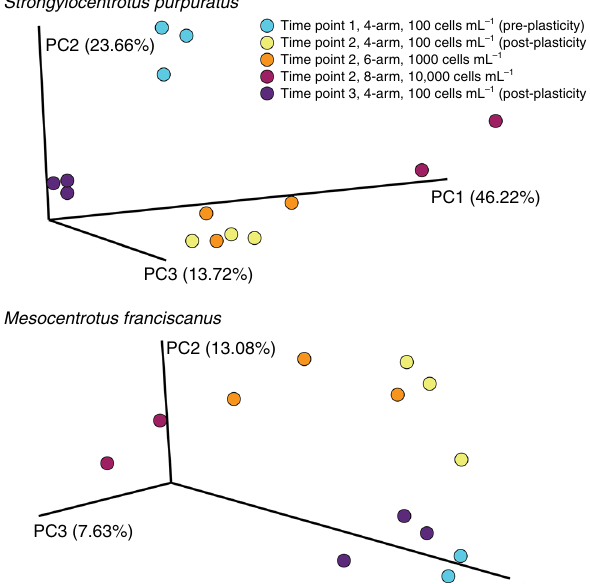
Fig. 5 Decoupling phenotype-speci fi c microbial communities from diet, development, and time for two species of echinoid larvae. Community similarity of the associated microbiota for Strongylocentrotus purpuratus ( a ) and Mesocentrotus franciscanus ( b ) larvae at the 8- (maroon), 6- (orange), and 4-arm (yellow) stage having been fed 10,000; 1000; and 100 cells mL − 1 , respectively, in comparison with larvae pre-expression (blue) and post- expression (purple and yellow) of phenotypic plasticity